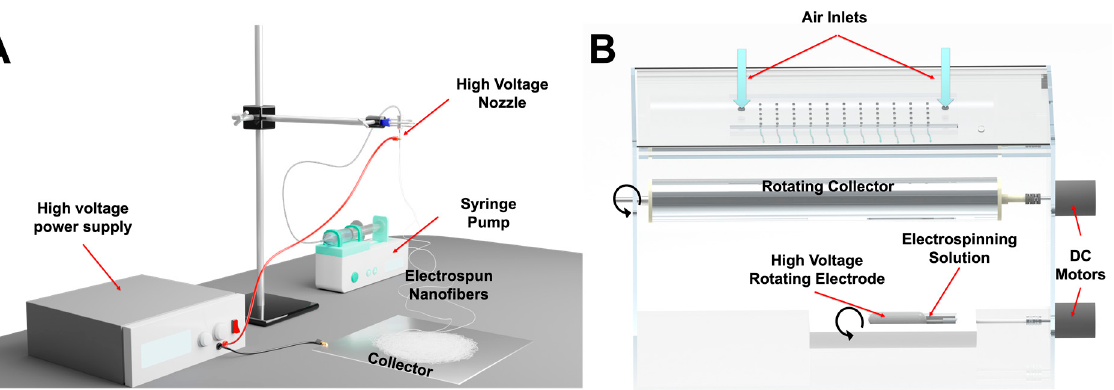
Figure 1. Schematic image of the two different electrospinning systems used in this study. ( A ) Con- ventional vertical nozzle-based electrospinning setup. A syringe pump delivers the electrospinning solution to the high-voltage nozzle. The collector plate has a negative bias. ( B ) Home-built nozzle-free high-throughput electrospinning setup. Positive high voltage is applied to the rotating electrode inside a solution bath. The rotating collector is also on high voltage, but with negative polarity. Air with controlled humidity enters the chamber from the